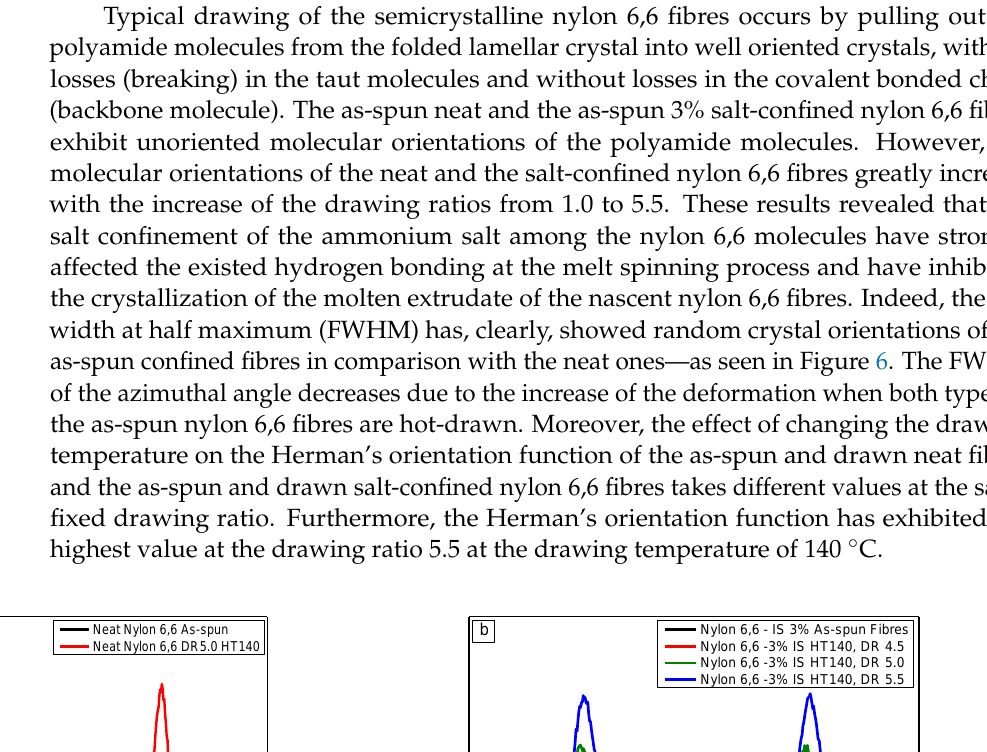
Figure 7. The orientation angle of the salt-confined nylon 6,6 fibres versus the drawing ratios of 1.0, 4.5, 5.0 and 5.5 at different drawing temperatures.